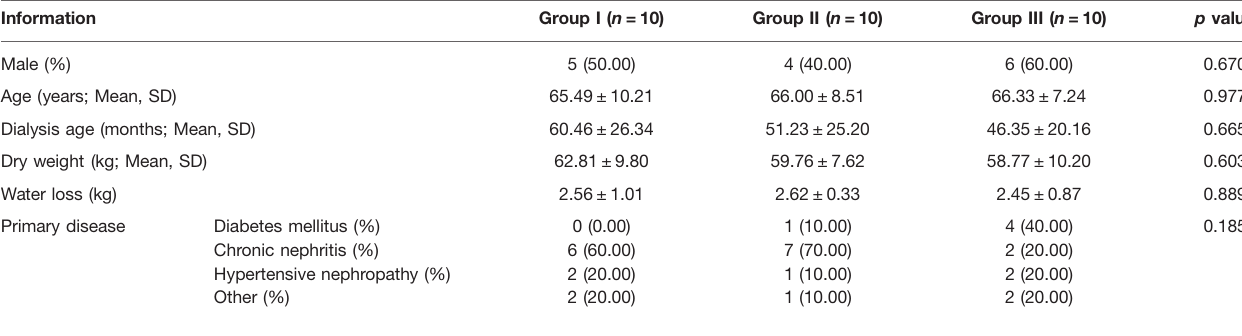
TABLE 1 | Comparison of general data between HD different BP patient